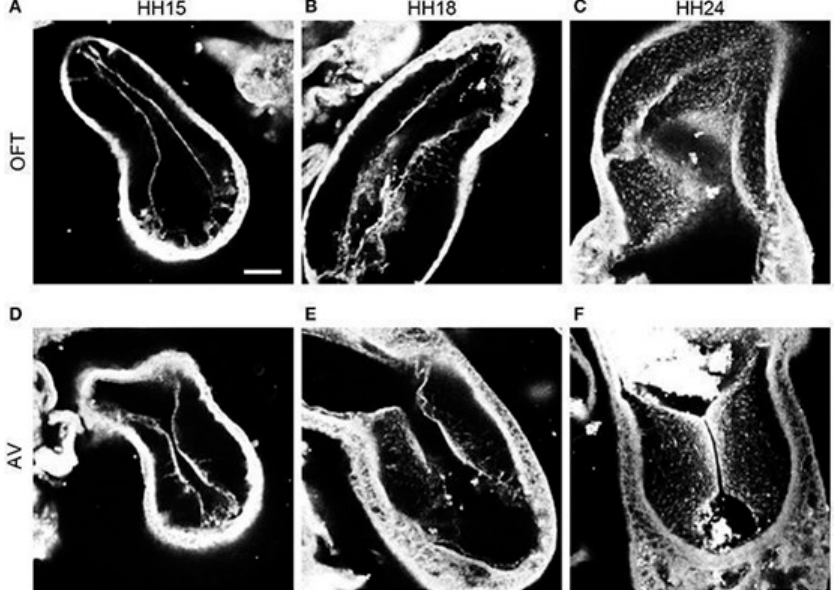
Figure 2. Progression of endothelial-mesenchymal transition (Endo-MT) in chicken endocardial cushions. Confocal fluorescent images were obtained at 20× from whole-mount embryo hearts stained with phalloidin to contrast cell content. ( A – C ) Outflow tract (OFT) cushions at progressive early developmental stages (HH15, HH18 and HH24, respectively). ( D – F ) Atrioventricular canal (AVC) cushions at progressive developmental stages (HH15, HH18, and HH24, respectively). Scale bar = 100 µm. Reproduced from [27], under Creative Common License.